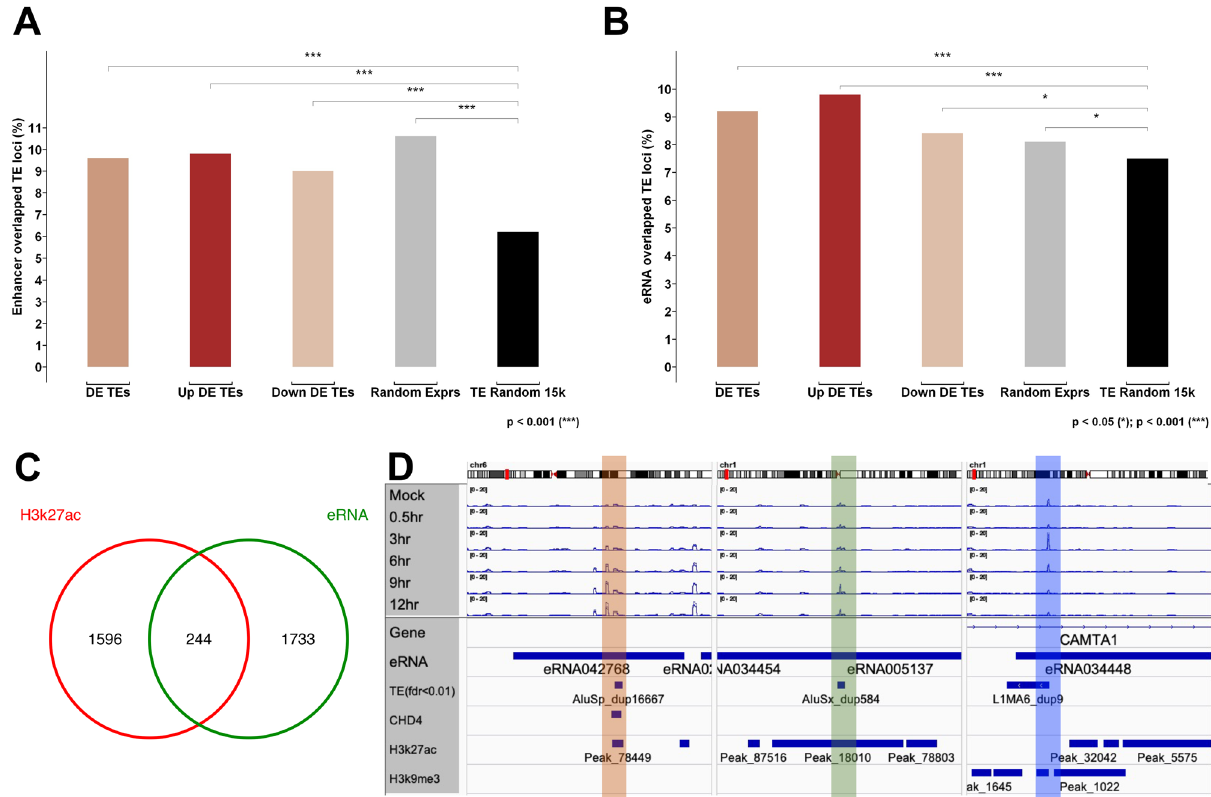
Figure 3. The spatial relationship between DE TEs and the predicted enhancers or eRNAs. ( A ) the DE TEs are significantly overrepresented in the predicted distal enhancer regions in contrast to random selected TEs (black), chi-square test. ( B ) using published eRNA dataset for verification, we found that the DE TEs are significantly overrepresented in eRNA regions, random selected TEs is the test control, chi-square test. ( C ) the 244 DE TEs that derived from H3K27ac occupied regions also overlap the eRNAs ( p < 0.05, hyper geometric test). ( D ) IGV displays the expression alteration of eRNA related DE TEs in the regions of CHD4 and H3k27ac enriched (left), H3k27ac alone (middle) and H3k9me3 alone